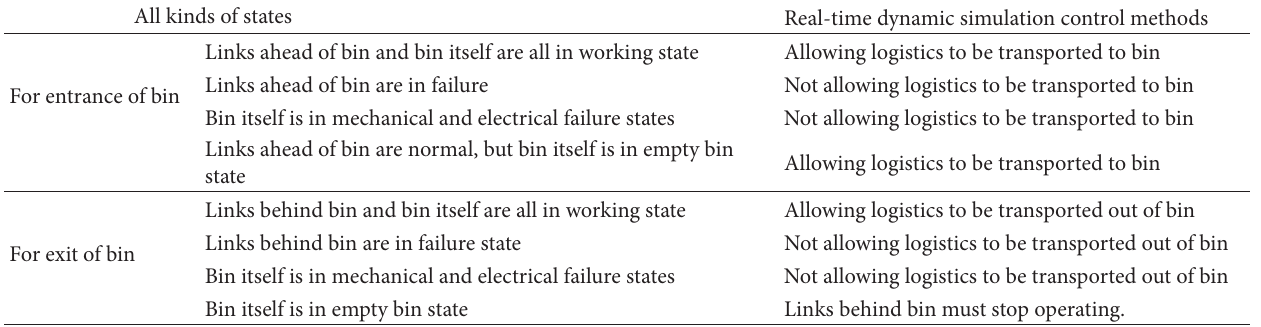
Table 1: The real-time dynamic control methods of simulated